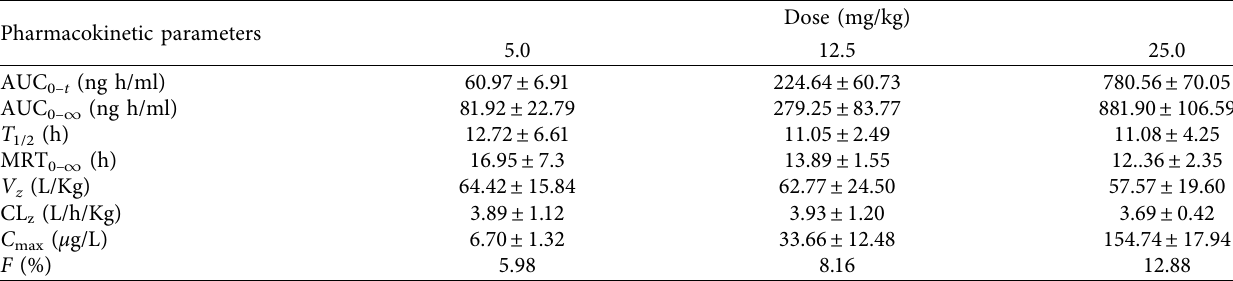
Table 6: Main pharmacokinetic parameters of liensinine after oral administration at three escalating doses (mean ± SD, n � 5 ).